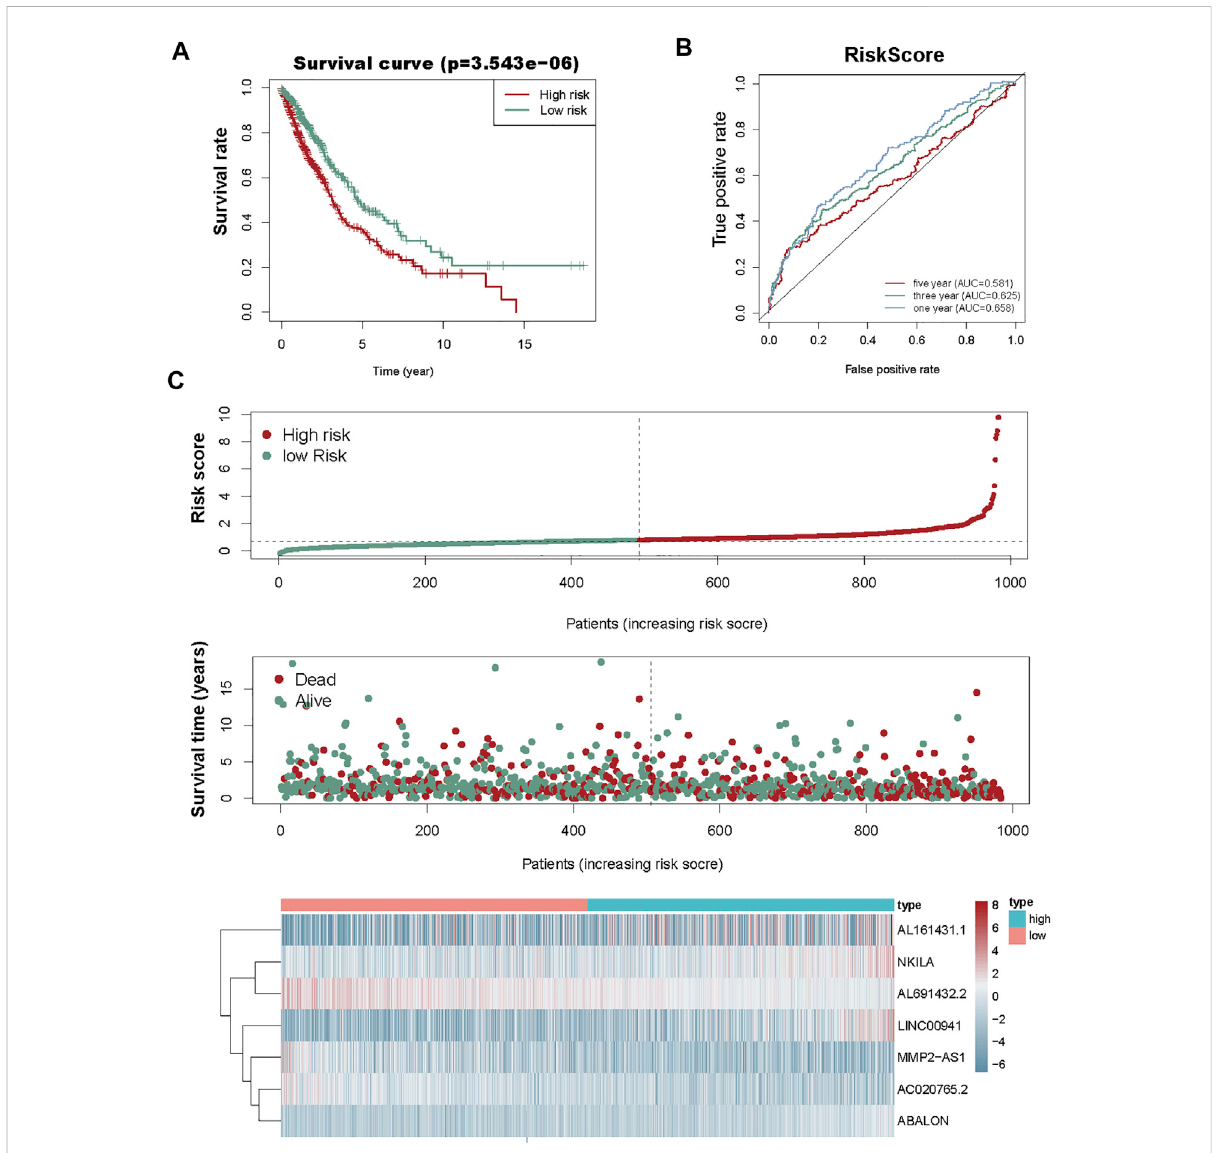
FIGURE 3 Risk score analysis of the prognostic model of these seven autophagy-associated lncRNAs. (A) KM survival analysis for high- and low-risk groups. Red, high risk. Green, low-risk. (B) ROC analysis to evaluate thepredictiveability of themodel. (C) Risk score distribution(top), survival status distribution (middle), and heat map of 7 autophagy-associated lncRNAs